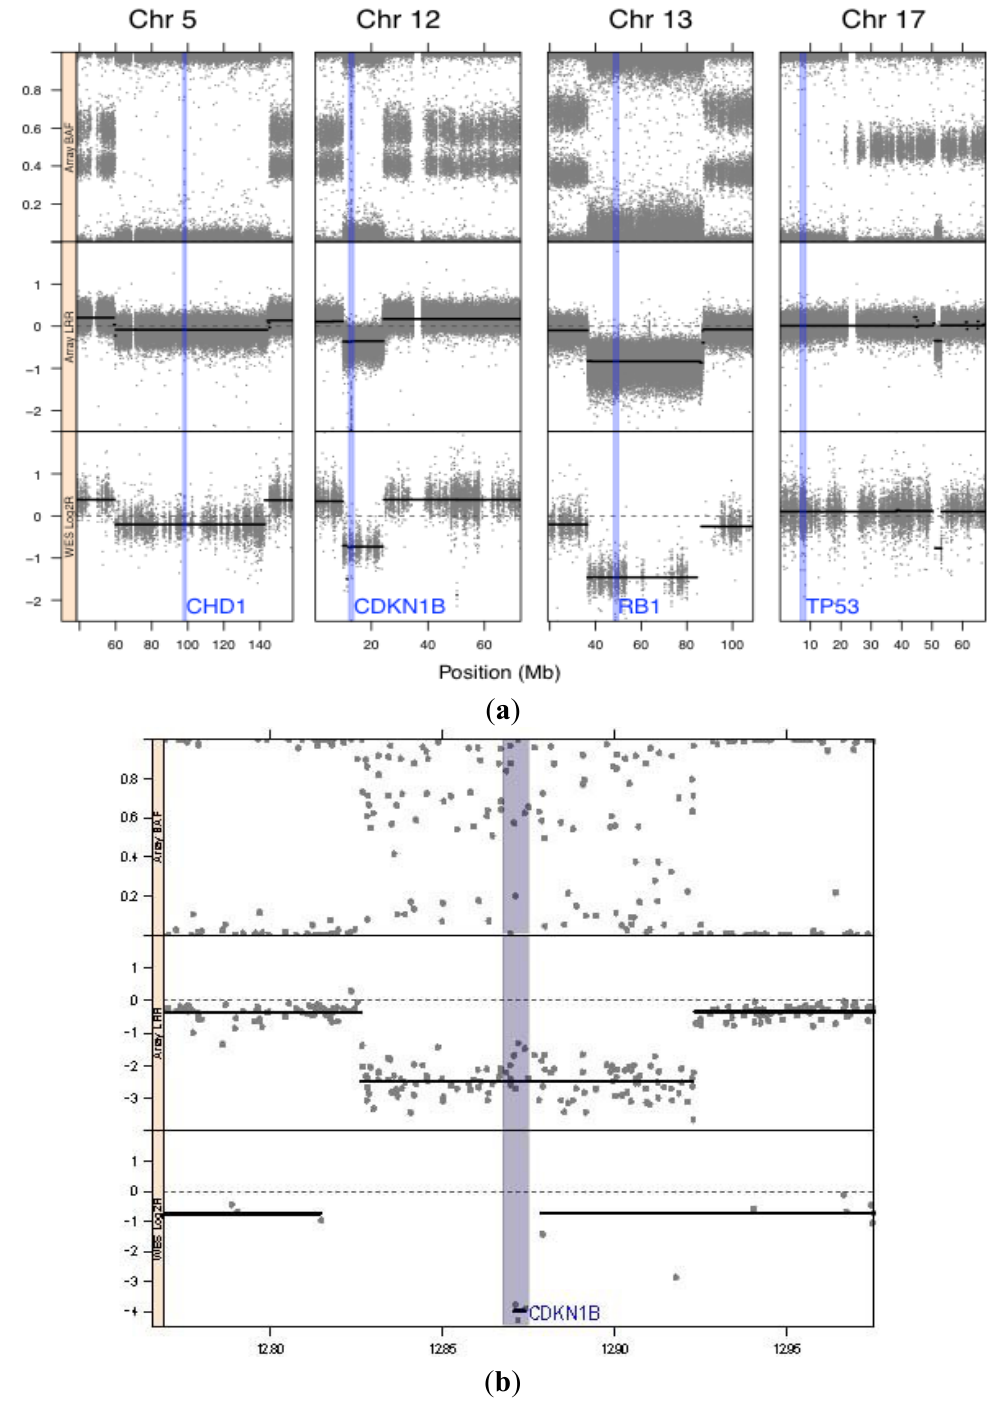
Figure 2. The location of the key genes described in the text. CHD1 (Chr 5: 98.190–98.265 Mb) was not mutated but occurs in a block of LOH; CDKN1B (Chr 12: 12.870–12.875 Mb) has low copy number, RB1 (Chr 13: 48.878 Mb–49.056 Mb) occurs in a block of LOH, has reduced copy number and the retained allele is predicted to be damaging; TP53 (Chr 17: 75.712 Mb–75.909 Mb) occurs in a copy neutral block of LOH and the retained allele is predicted to be damaged. Figure 2b, magnified view of the CDKN1B region showing a likely deletion of the gene supported by both the array (top and middle panels) and exome-sequencing platforms